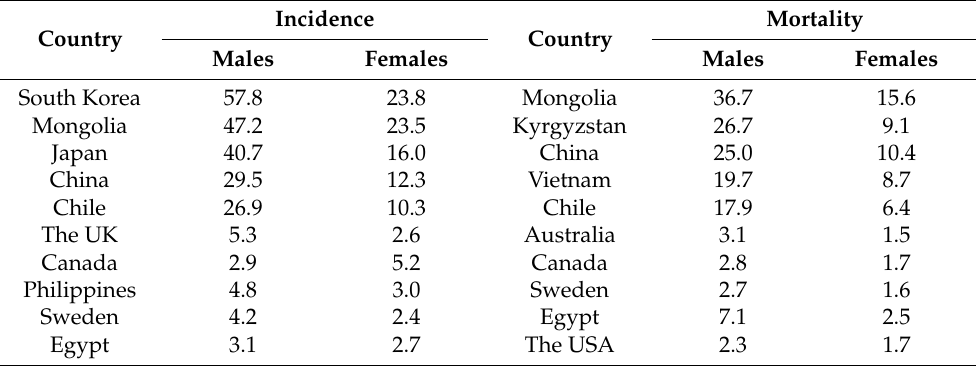
Table 1. Countries with the highest and lowest incidence and mortality rates of stomach cancer in